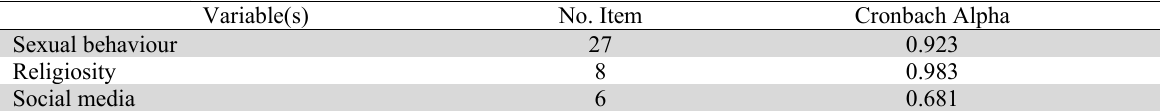
Results of Reliability Measurement Scales